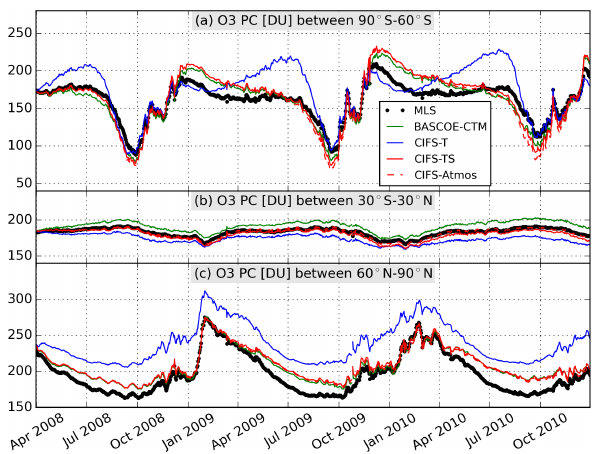
Figure 2. Daily averages of O 3 partial columns (10–100hPa) for the Arctic (60–90 ◦ N), tropics (30 ◦ S–30 ◦ N) and Antarctic (60– 90 ◦ N) over the period April 2008–December 2010. Data sets are averaged in 5-day bins and model output is interpolated to the loca- tion and time of Aura MLS v3 retrievals (black dots). Blue line: C- IFS-T; green line: BASCOE-CTM; red dashed line: C-IFS-Atmos; red solid line: